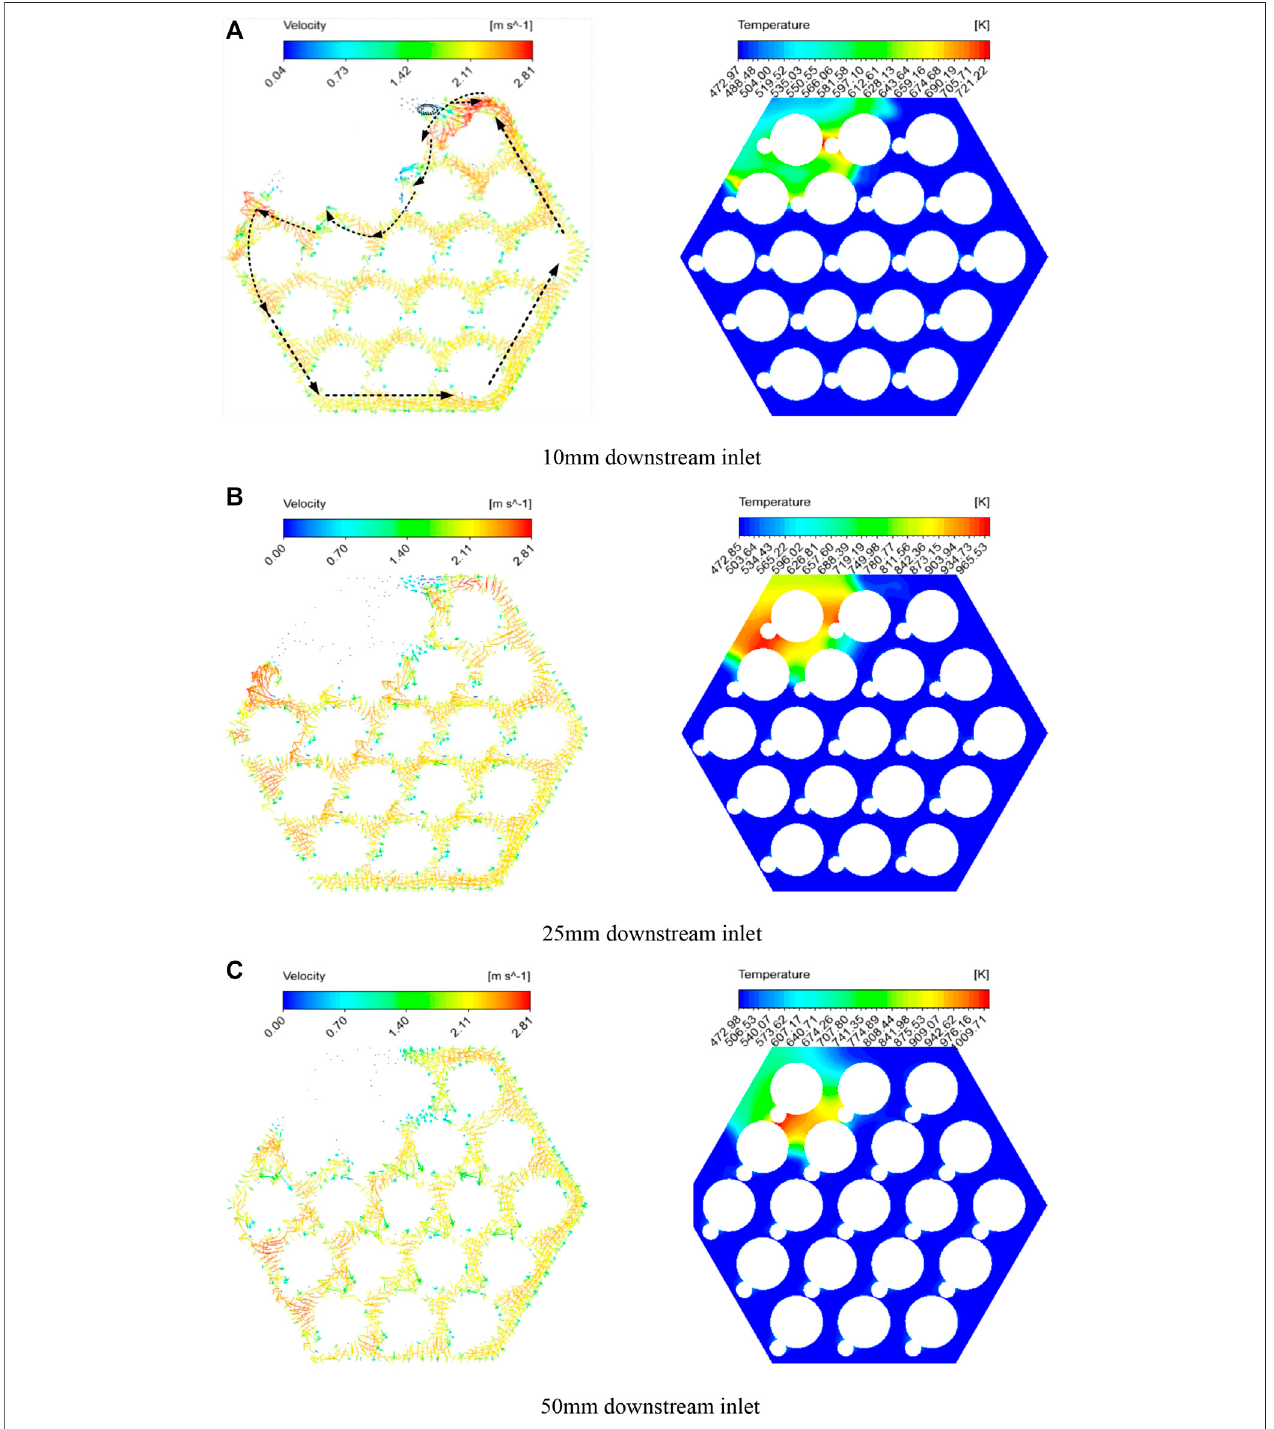
FIGURE 9 | Thevector andtemperaturecontoursincase3. (A) 10 mmdownstream oftheinlet. (B) 25 mmdownstream oftheinlet. (C) 50 mm downstreamoftheinlet. (D) 25 mm downstream of the blockage. (E) 50 mm downstream of the blockage. (F) 75 mm downstream of the blockage.